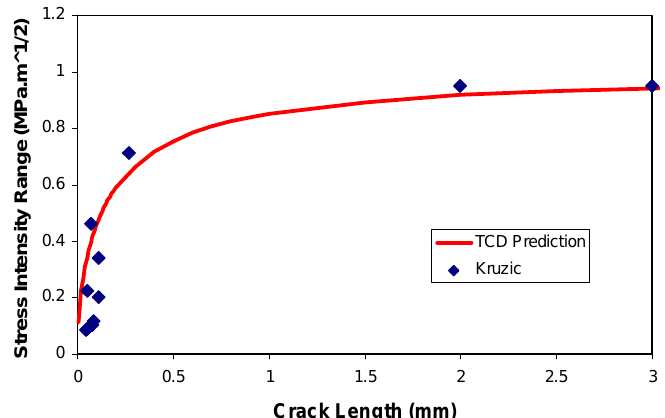
Figure 3: Threshold stress intensity range for fatigue crack growth in bone, defined at a crack growth rate of 3-6 x 10 -8 m/cycle; for details see